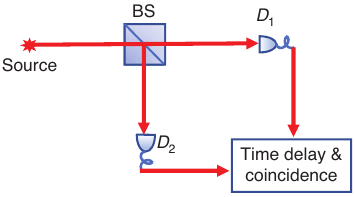
Figure 2: Diagram of the HBT interferometer. A pseudothermal beam of light is passed through a beam splitter (BS) and measured by two detectors D between the two detectors is controlled in this experiment, and the output signals produced by both detectors are correlated. This measurement is equivalent to the implementation of correlations of intensity fluctuations.